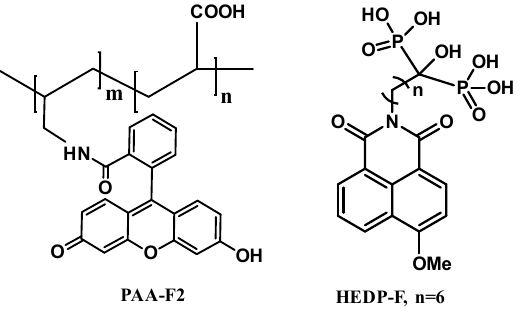
Figure 1. PAA-F2 and HEDP-F molecular structures.